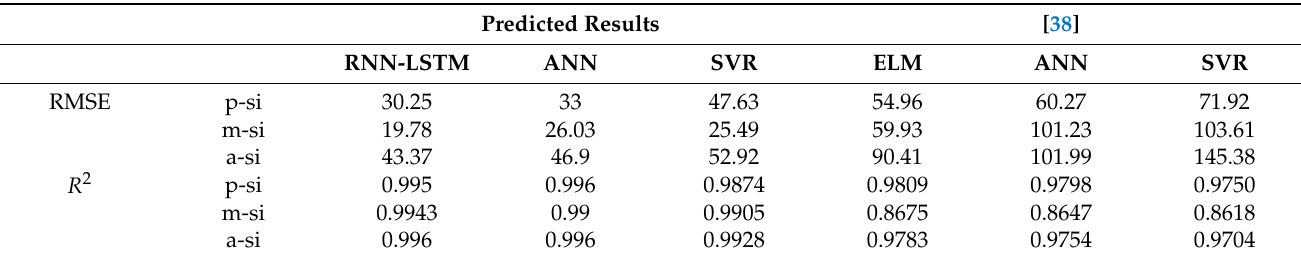
Table 3. Comparison of the suggested approach and benchmark methodologies in forecasting accuracy for different PV modules for the year 2016.